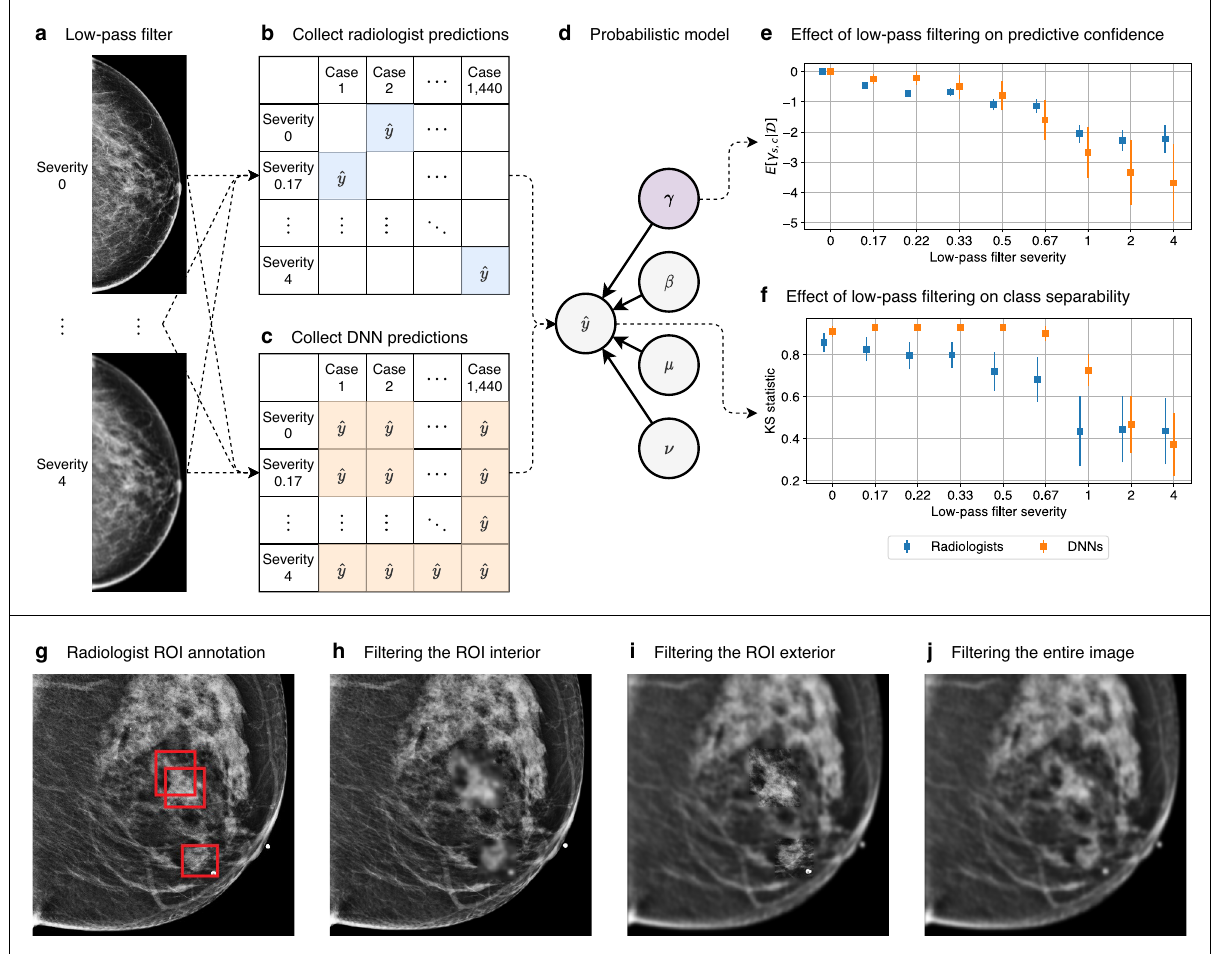
Figure 2. Our framework applied to breast cancer screening. (a–f) Comparing radiologists and DNNs with respect to their perturbation robustness. (a) We applied low-pass filtering to a set of mammograms using a wide range of filter severities. (b) We conducted a reader study in which each reader was provided with the same set of mammograms. Each reader saw each exam once, and each exam was filtered with a random